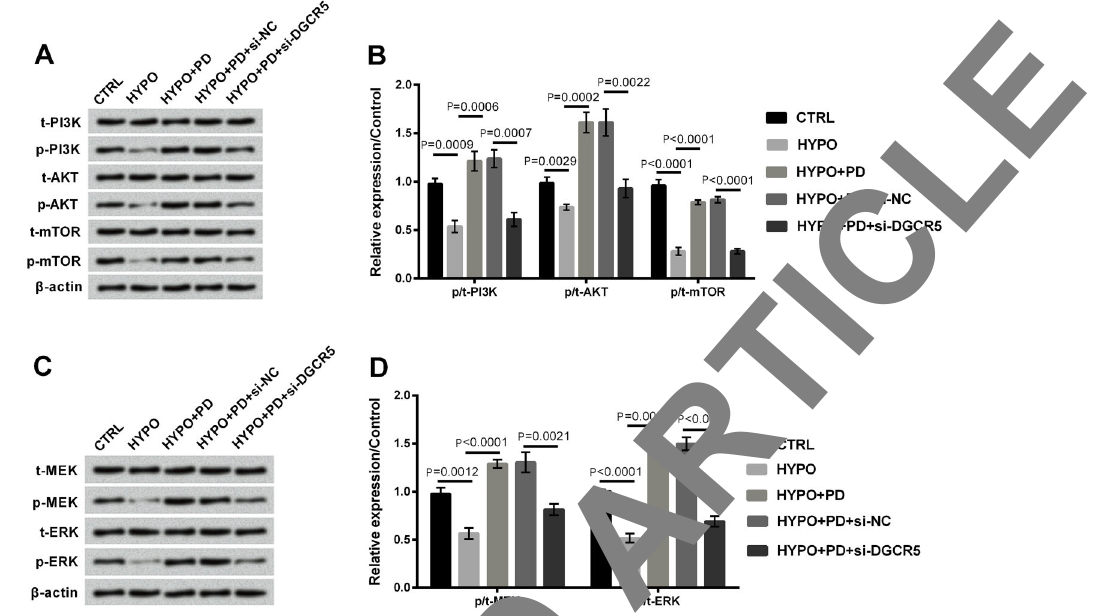
Figure 5. Polydatin (PD) activated the PI3K/AKT/mTOR and MEK/ERK pathways. A and B , The total protein expression levels of PI3K, AKT, mTOR as well as phosphorylated PI3K, AKT, mTOR were analyzed by western blot. C and D , The total protein expression levels of MEK and ERK, as well as phosphorylated MEK and ERK were analyzed by western blot. Data are reported as mean ± SD